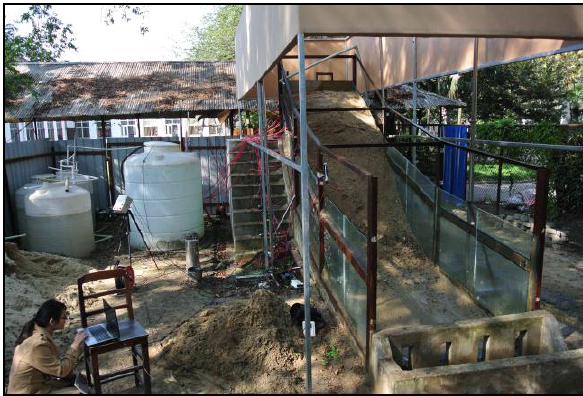
Figure 2. The landslide simulation platform established at Tongji University, Shanghai.